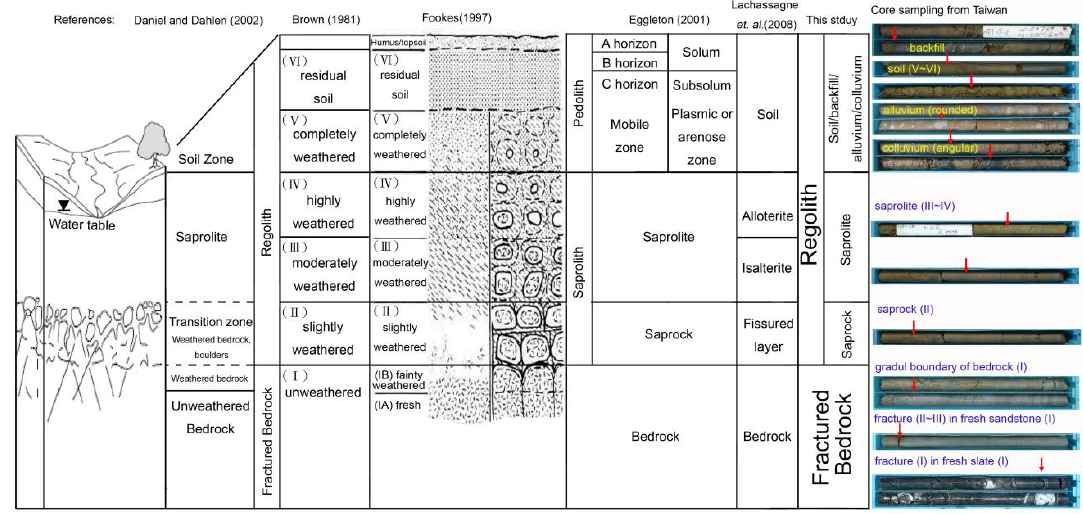
Figure 1. Hydrogeological setting of mountainous regions and core sampling in the case study.